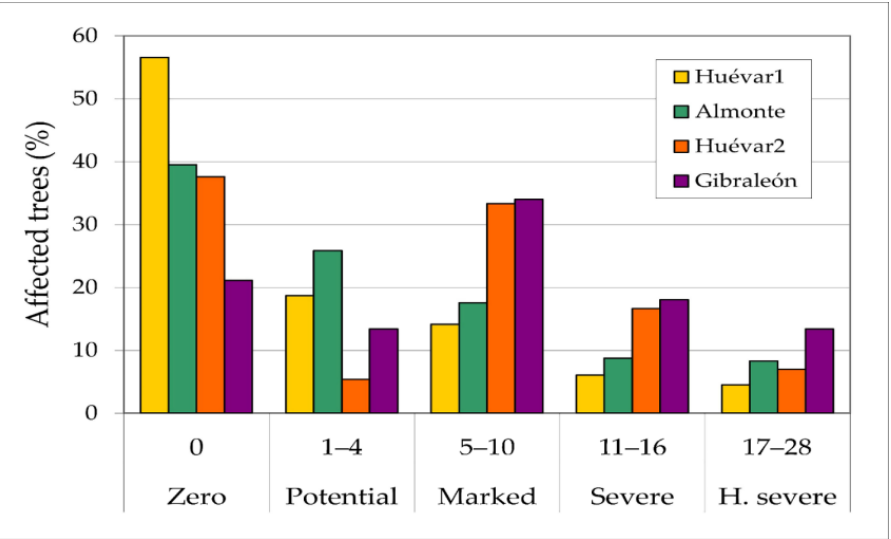
Figure 5. Percentages of trees affected by wood borer insects in each study plot, according to damage categories.